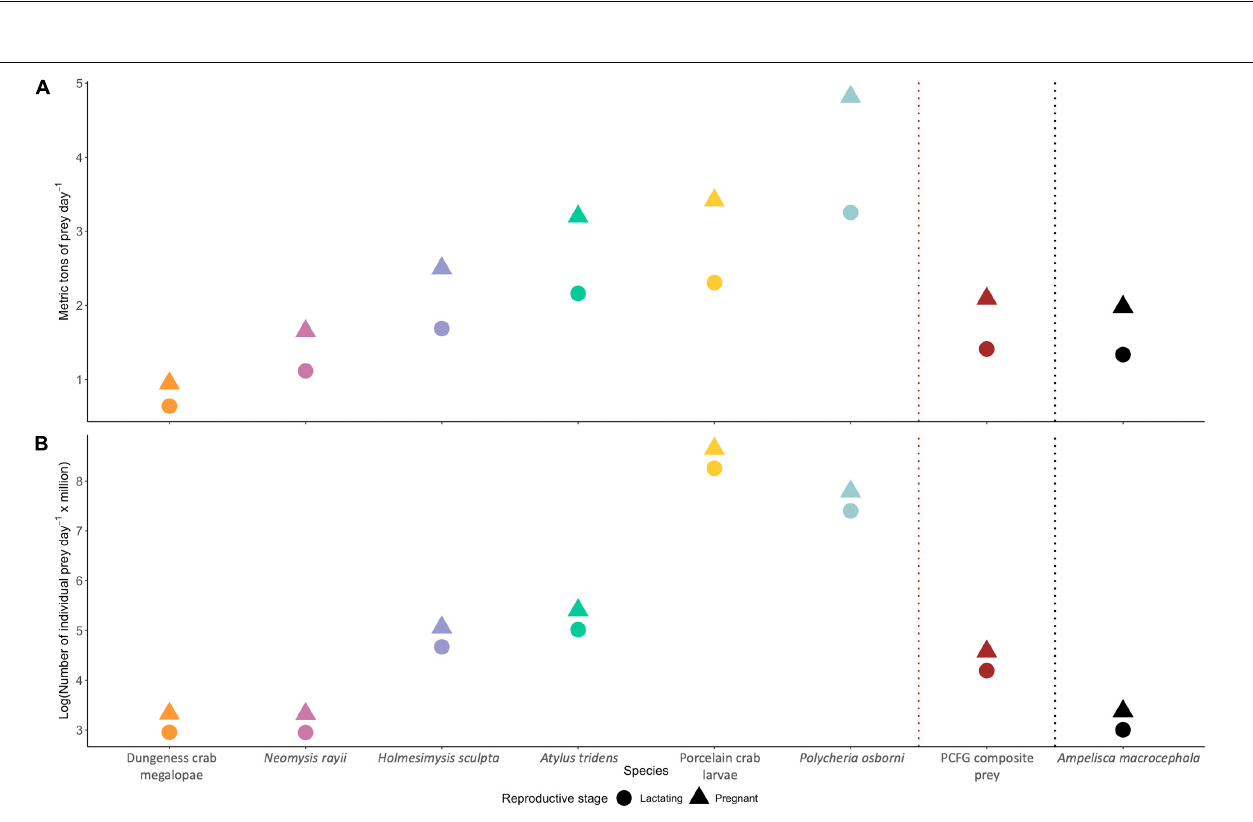
Frontiers in Marine Science |